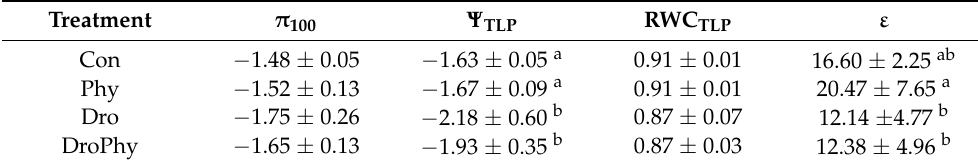
Table 1. Osmotic potential at full turgor (π 100 ), water potential at turgor loss point (Ψ TLP ), relative water content at turgor loss (RCW TLP ) and bulk modulus of elasticity (ε) for Eucalyptus obliqua trees under well-watered control conditions or subjected to drought and Phytophthora infection. Data are means with standard error ( n = 6). Treatments with the same letter do not differ significantly at p ≤ 0.05, after ANOVA and LSD test. Treatment